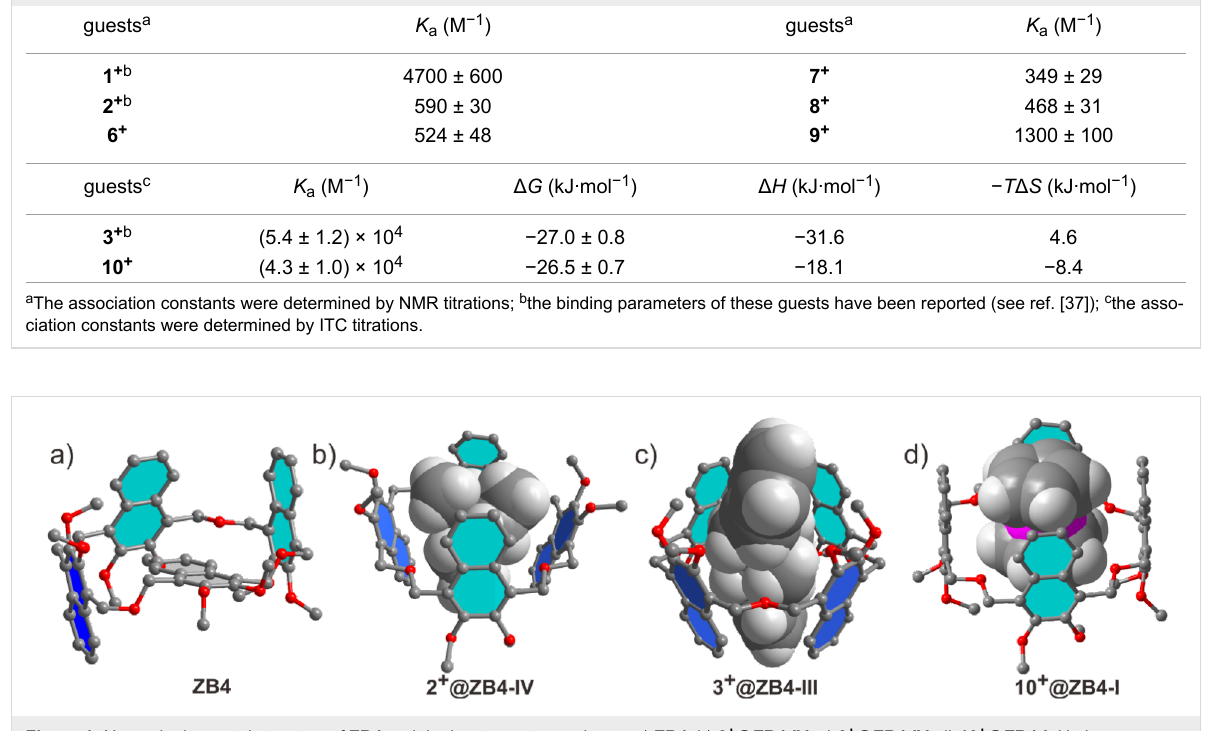
Table 1: Association constants (M − 1 ) and other thermodynamic parameters as determined by 1 H NMR titrations (400 MHz, CD 2 Cl 2 /CD 3 CN 1:1, 298 K) or by ITC titrations in a 1:1 mixture of 1,2-dichloroethane and MeCN at 298 K.